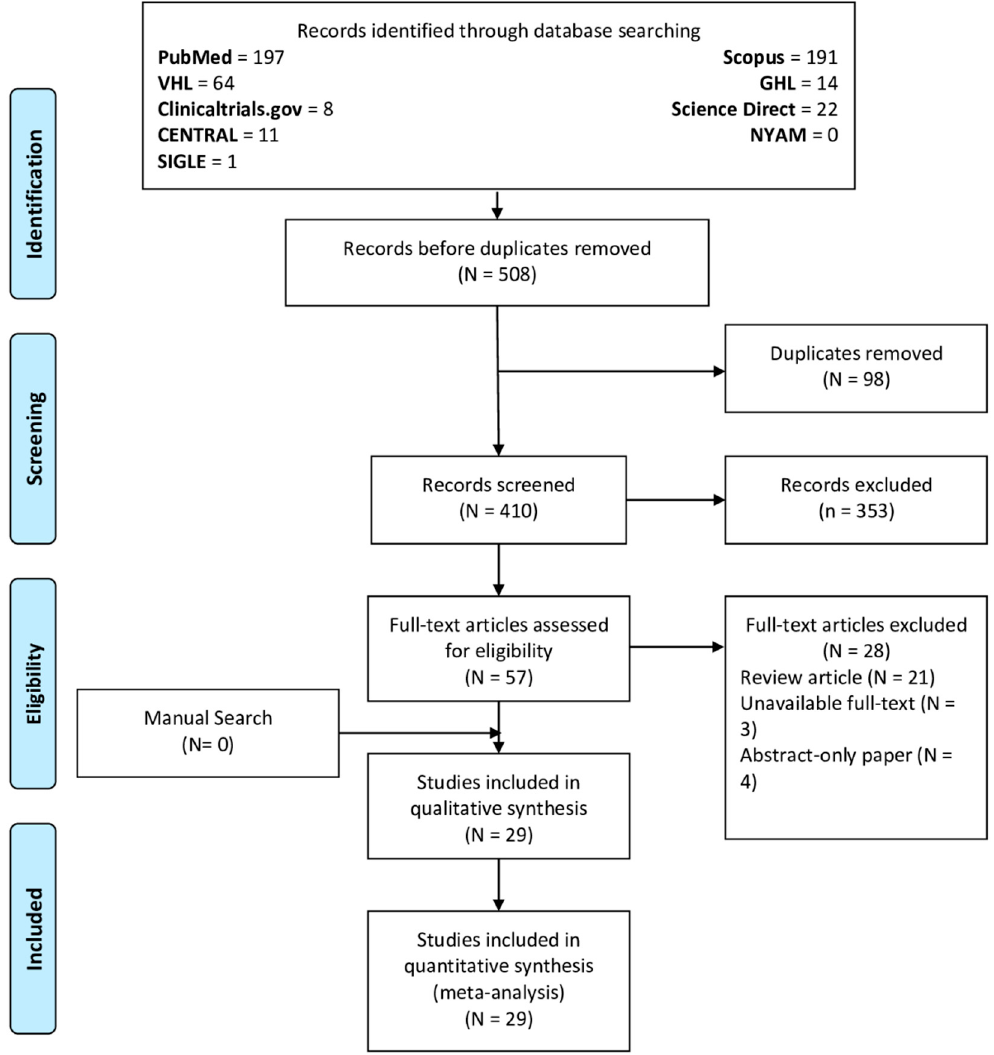
Figure 1. PRISMA flow diagram of the review process.